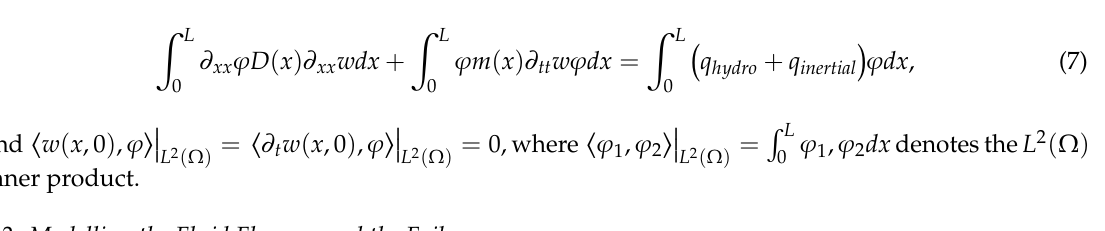
Figure 2. The body-fixed Cartesian coordinate system denoted by ( x ’, z ’) fixed at the foil’s centre of rotation